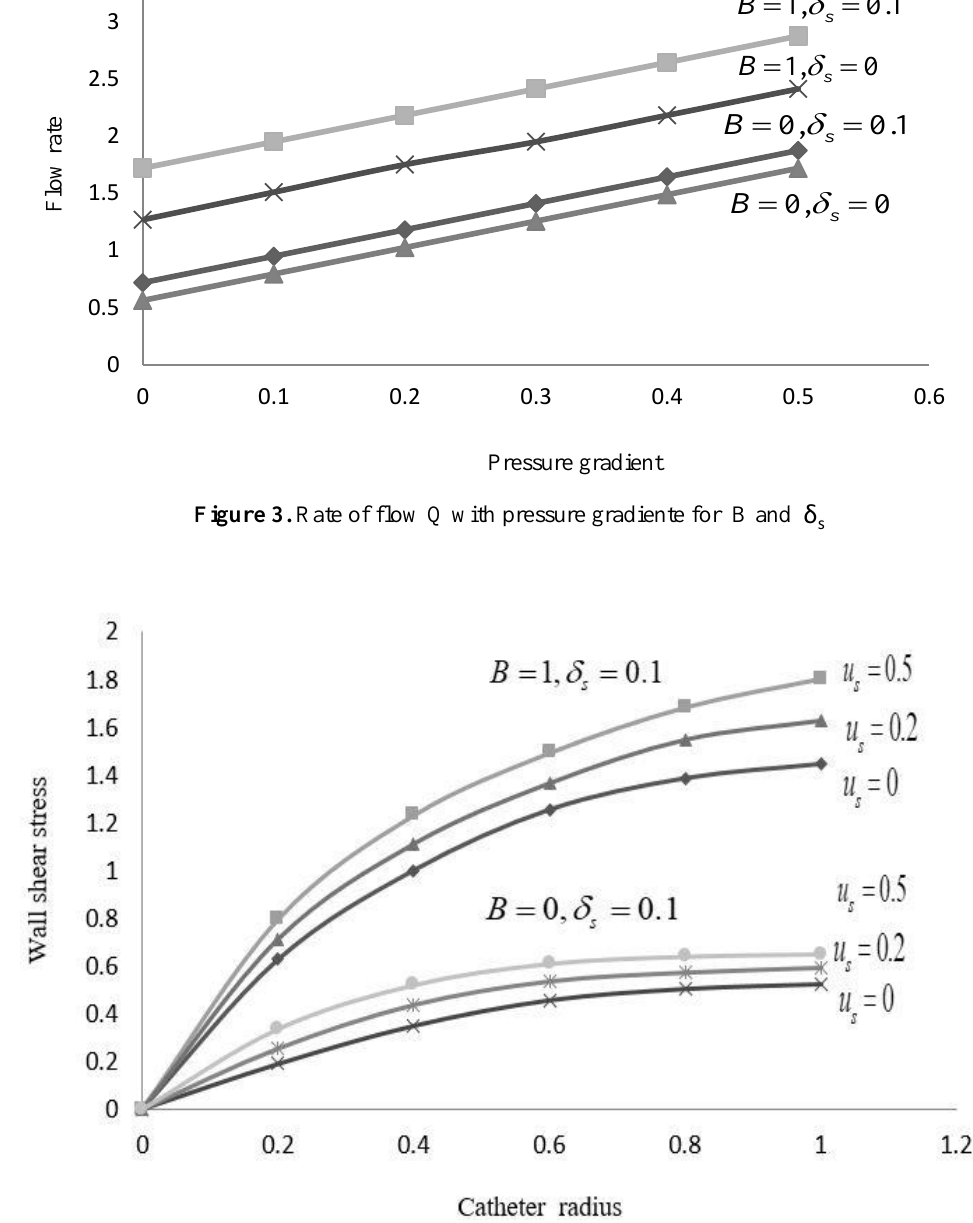
Figure 4. Shear stress with catheter radius for slip velocity.